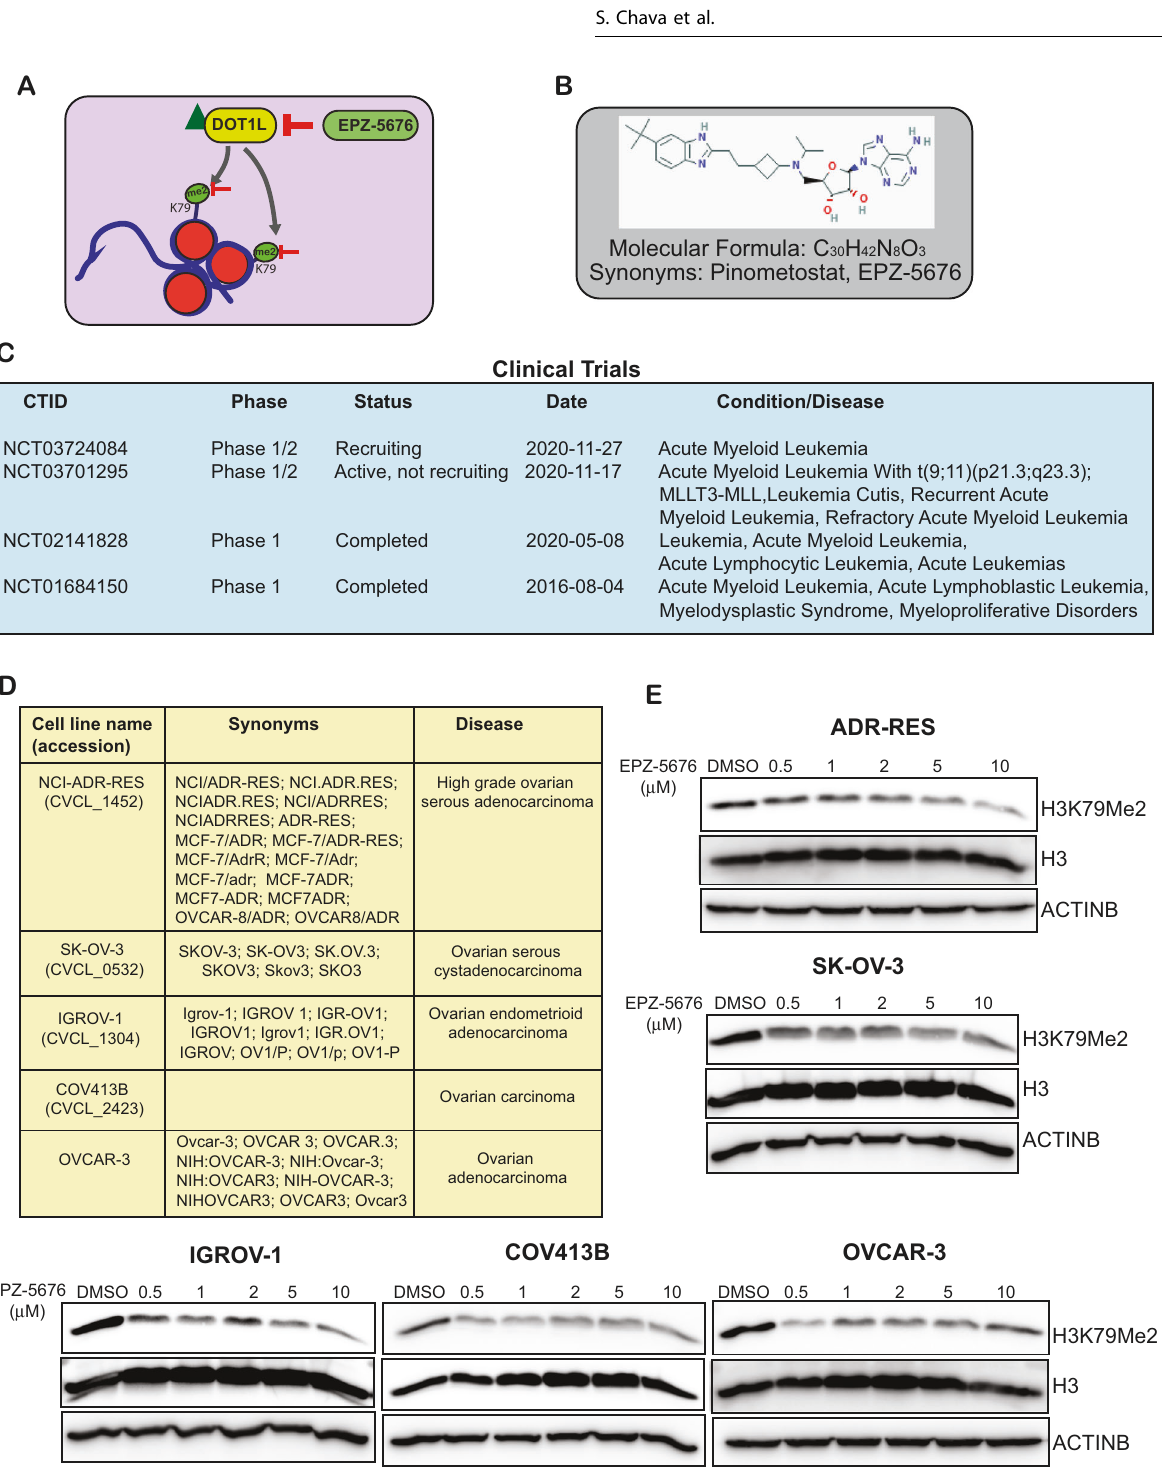
Fig. 2 The DOT1L inhibitor EPZ-5676 inhibits H3K79me2 mark in ovarian cancer cell lines. A Schematics showing how DOT1L regulates the H3K79 dimethyl mark and how the pharmacological inhibition of DOT1L via EPZ-5676 leads to suppression of the mark. B EPZ-5676 inhibitor structure and formula. C EPZ-5676 inhibitor studies in clinical trials as reported on ClinicalTrials.gov. D The common names, synonyms, and disease associations of the ovarian cancer cell lines used in this study. E The indicated ovarian cancer cell lines were treated with various concentrations of the DOT1L inhibitor EPZ-5676 for 48 h. H3K79 dimethyl marks were then measured. Histone H3 and ACTINB proteins were measured as loading